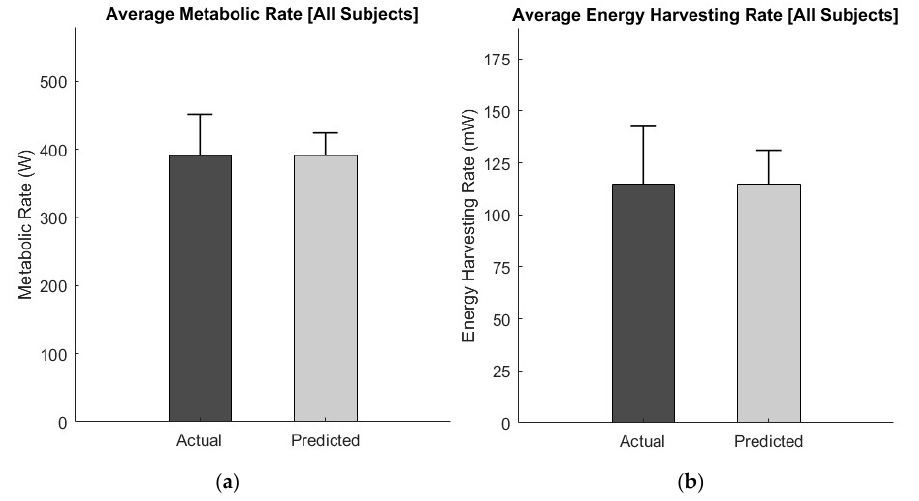
Figure 3. ( a ) Overall actual and predicted average metabolic rates. There was no statistical difference between actual and predicted average metabolic rates. ( b ) Overall actual and predicted average energy harvesting rates. There was no statistical difference between actual and predicted average energy harvesting rates.